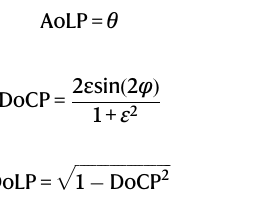
Fig. 21. The average measurement errors of S 1 , S 2 , and S 3 are 14.2%, 15.2%, and 5.4%, respectively. The relative higher measurement errors for S 1 and S 2 than that for S 3 can be attributed to the